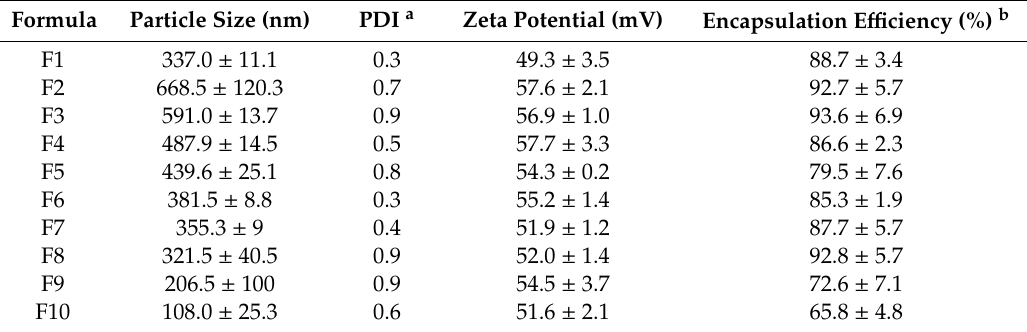
Table 2. LeciPlex particle size, polydispersity index, zeta potential, and drug encapsulation e ffi ciency of di ff erent